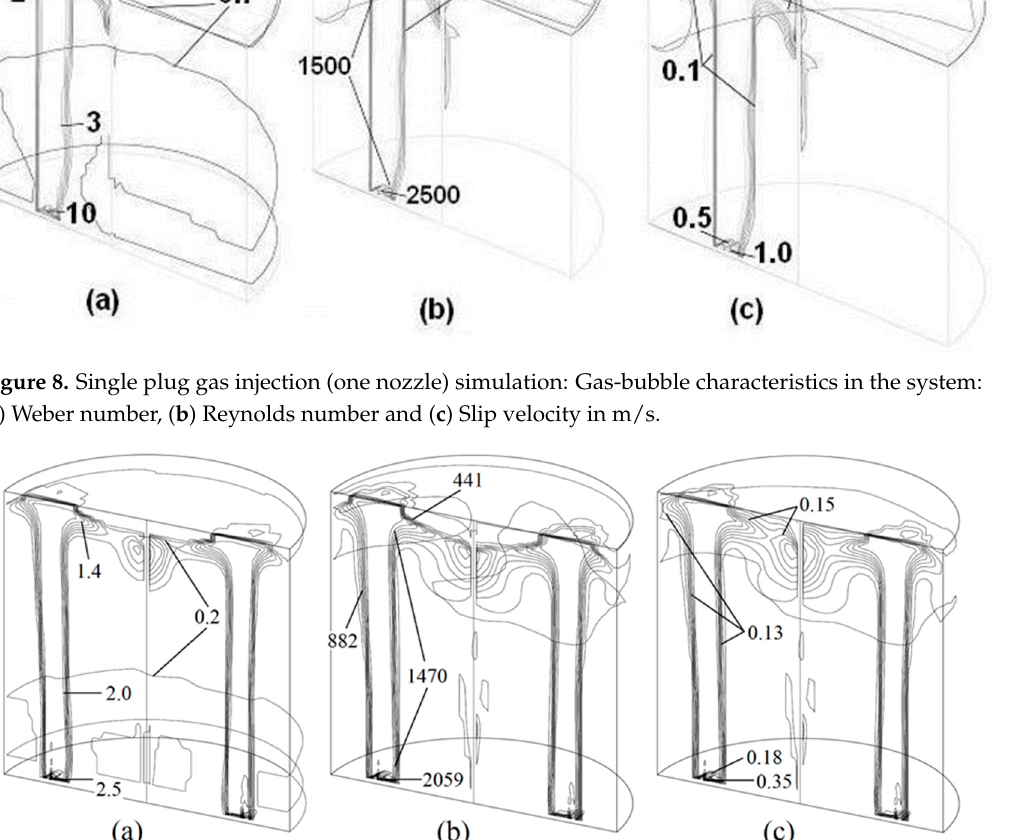
Figure 9. Dual plug gas injection (two nozzles) simulation: Gas-bubble characteristics in the system: ( a ) Weber number, ( b ) Reynolds number and ( c ) Slip velocity in m/s.